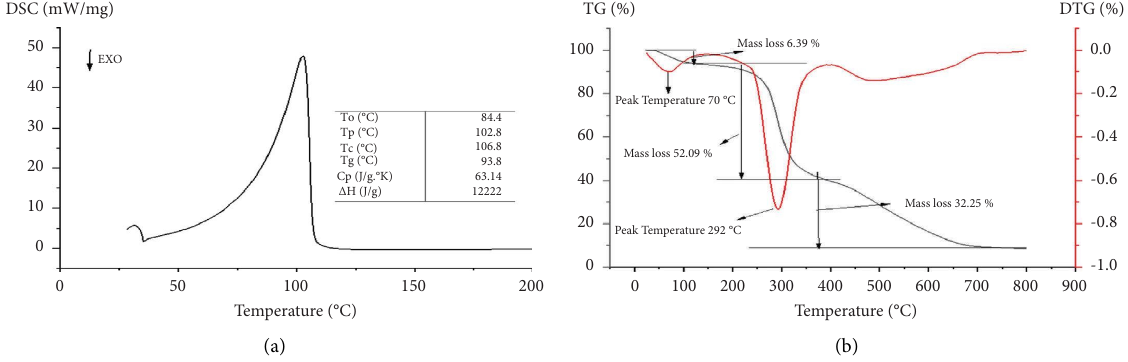
Figure 6: Termal analysis of green banana four: (a) Diferential scanning calorimetric (DSC). (b) Termogravimetric analysis (TGA) and diferential thermogravimetric analysis (DTGA).